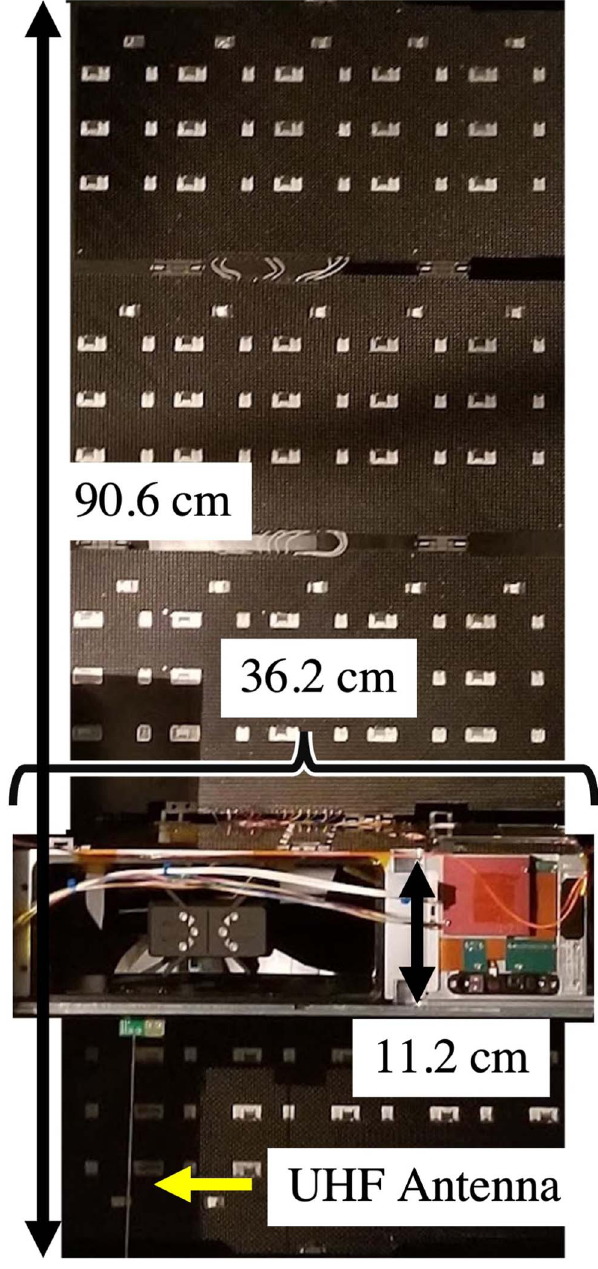
Figure 1. The CUTE spacecraft with solar panels fully deployed and communication cables attached. Solar cells are opposite the telescope boresight. The telescope is visible in the left 2 / 3 of the spacecraft and the star tracker and avionics are contained in the right 1 / 3. The star tracker has a red “ remove before fl ight ” panel covering its aperture. The UHF antenna is deployed on the bottom left of the spacecraft chassis and is noted with the yellow